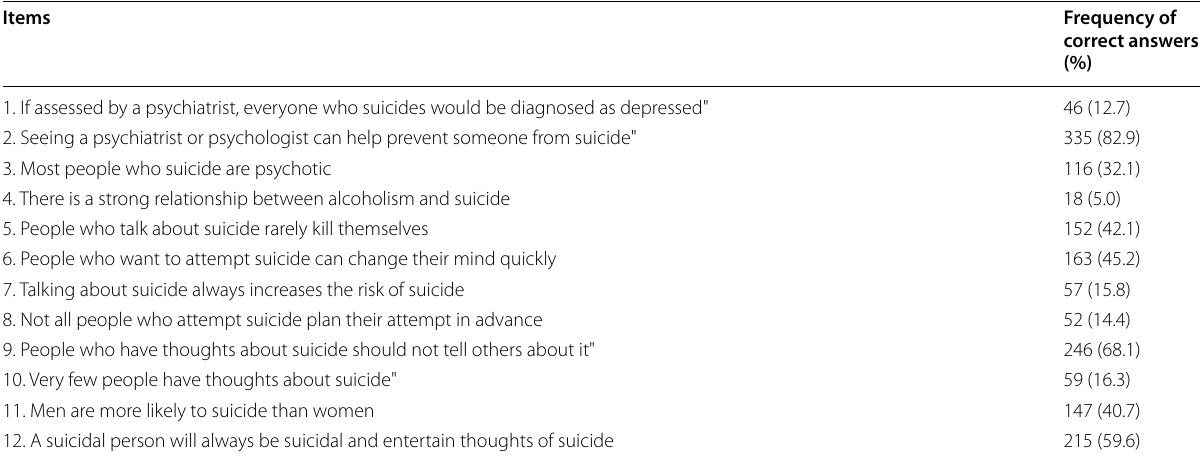
Table 3 Frequency distribution of correct answers to the suicide literacy scale Items